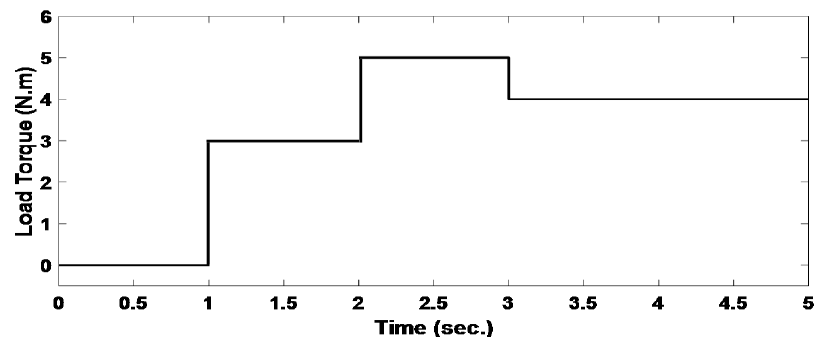
Figure 19. Proposed load torque.